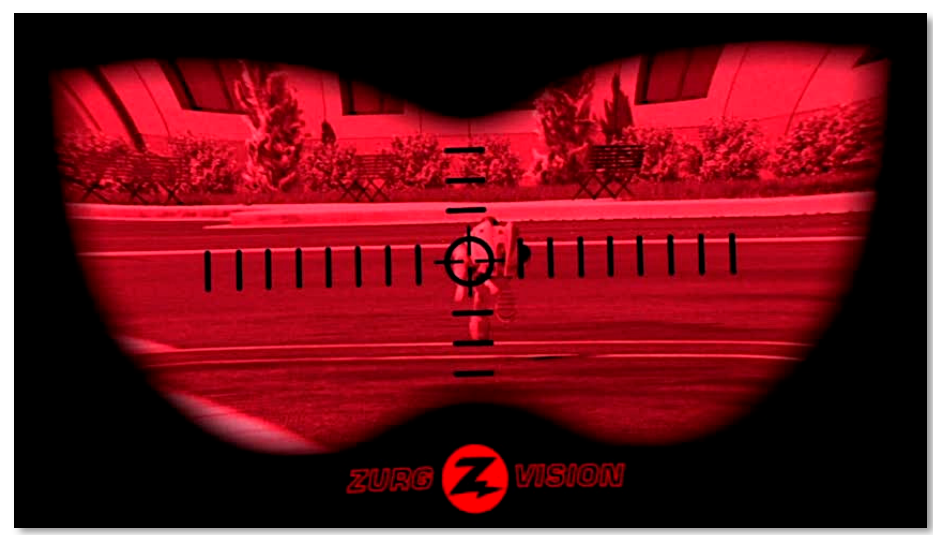
Figure 10. Image from Toy Story 2 (1999) [43].